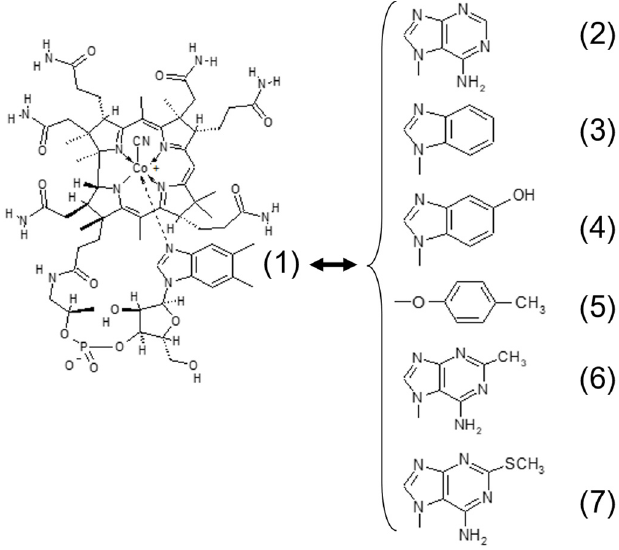
Figure 3. Structural formula of B 12 and partial structures of B 12 -related compounds. (1) B 12 , (2) PseudoB 12 , (3) BIA, (4) Factor III, (5) p -cresolyl dicyanocobamide, (6) Factor A, and (7) Factor S.